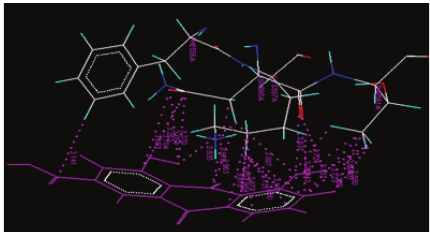
Figure 3: Van der Waals interaction of AEC with protein 4COX.